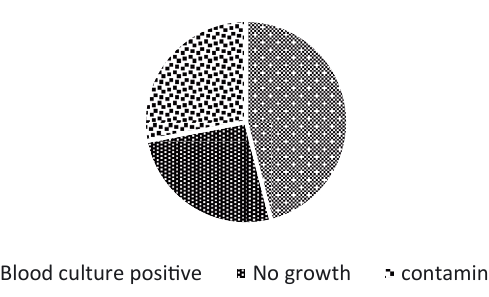
Figure2: Distributionofbloodculturepositiveamongcontrolgroup population.